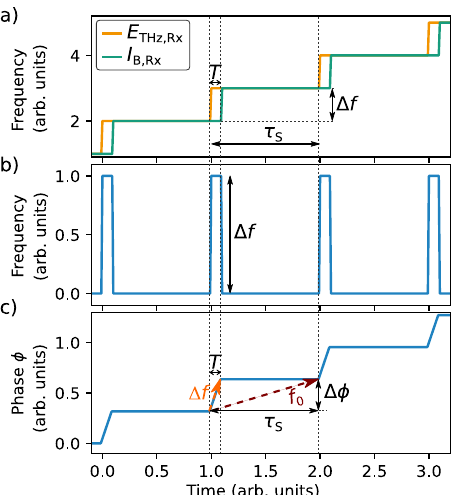
Fig. 2 Illustration of the time-dependent detector signal of a FMCW THz spectrometer with stepwise frequency tuning. a Frequency of the incident THz fi eld E THz,Rx and the optical beat note I B,Rx at the receiver as a function of time. The time delay T between E THz,Rx and I B,Rx , the frequency step size Δ f and the cycle time τ s are indicated. b Time-dependent frequency and c phase of the electrical signal after photomixing in the receiver. Frequency and phase of the receiver signal change by Δ f and Δ ϕ , respectively, within the time T . The quantity f 0 denotes the linearized intermediate frequency, which is used for signal detection in our realization of the FMCW THz